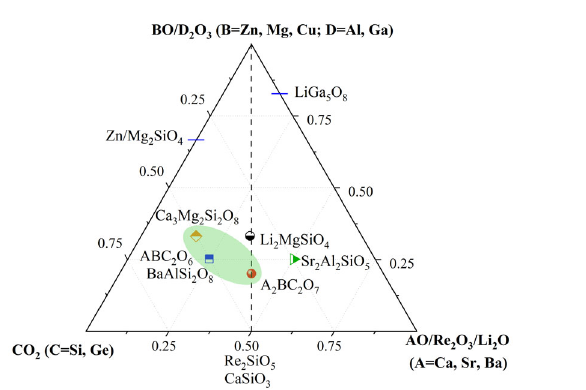
Fig. 3 Pseudo phase diagram of the silicate and